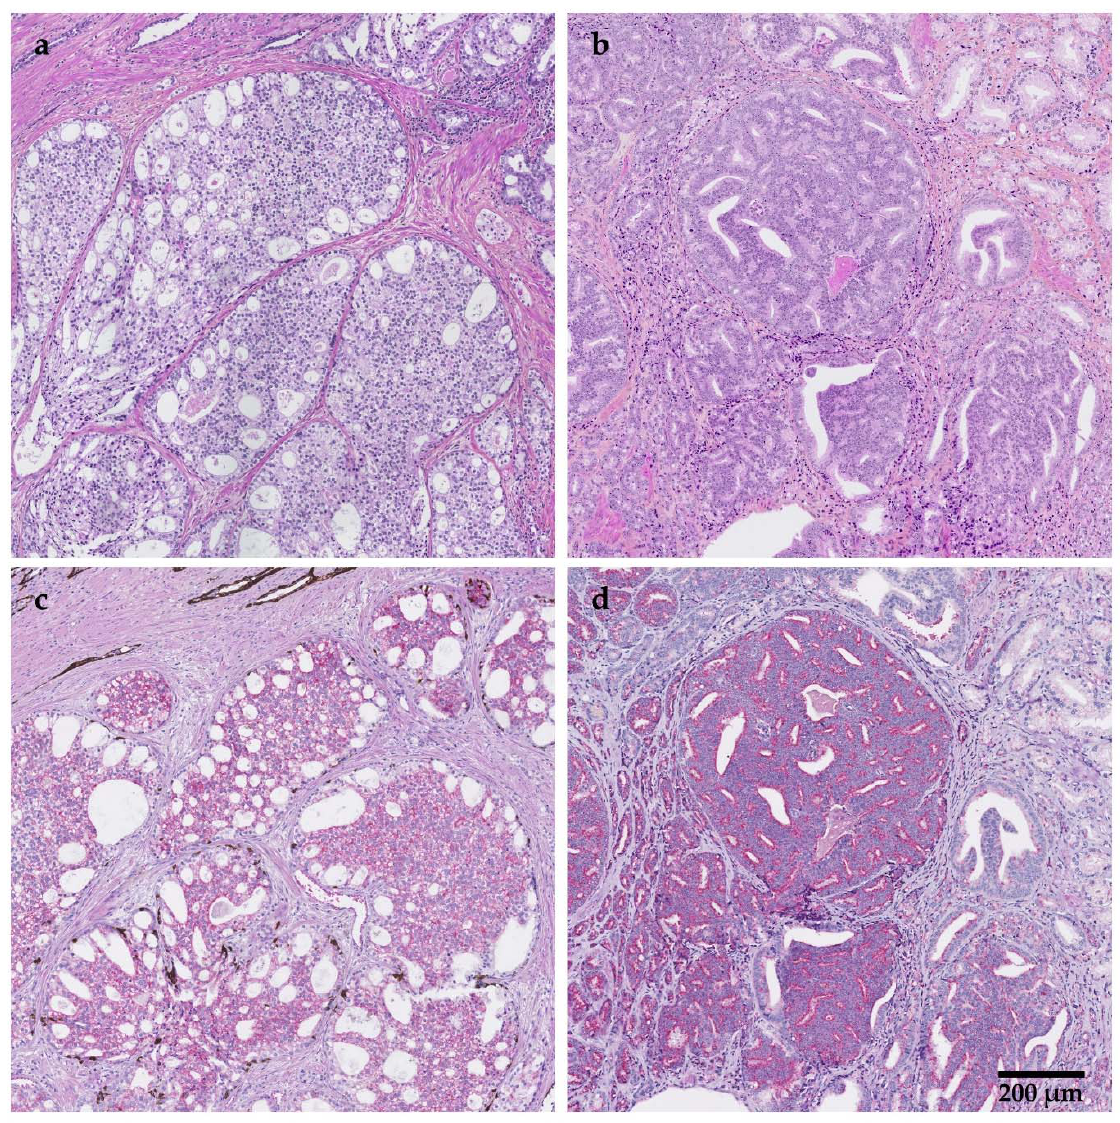
Figure 1. Intraductal carcinoma of the prostate (IDC ‐ P) ( a , c ) and cribriform type pattern 4 prostate cancer (CC) ( b , d ). Hematoxylin phloxine saffron staining ( a , b ) or immunostaining for high molecular weight cytokeratins and p63 (basal cell markers, brown) and α -methylacyl-CoA racemase (prostate cancer marker, red) with hematoxylin and eosin counterstaining ( c , d ), highlighting the basal cells surrounding IDC-P and the direct contact between CC and the tumour stroma. Scale bar: 200 μ m.